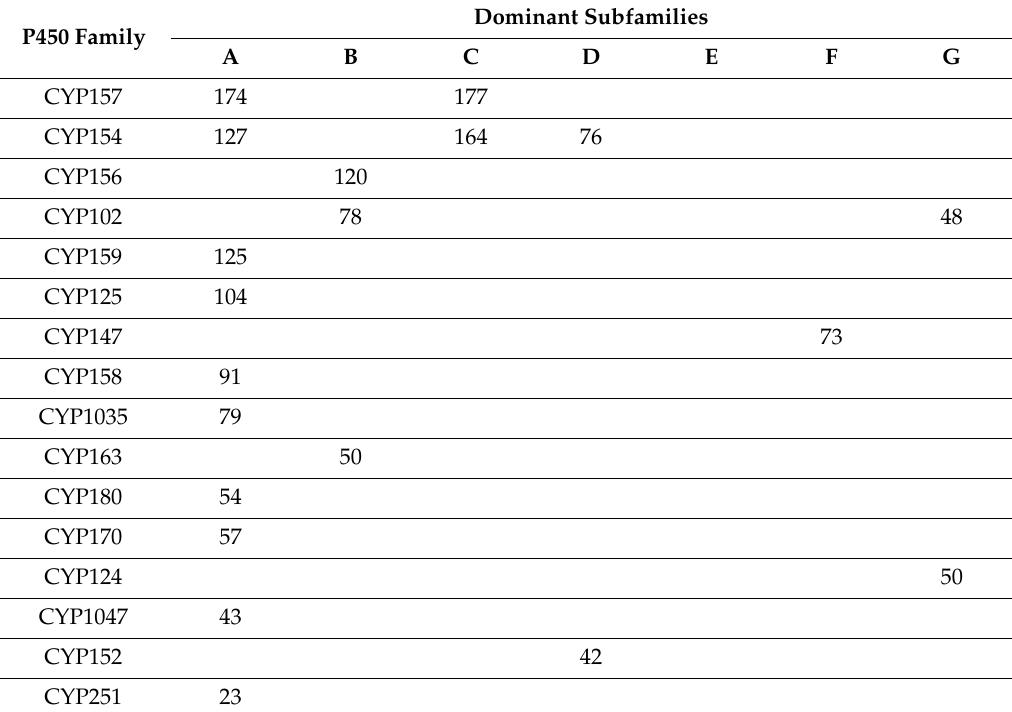
Figure 2. P450 family and subfamily analysis in 203 Streptomyces species. Only the dominant P450 families with more than 40 P450s are shown in the figure. Detailed data on P450 families and subfamilies are presented in Supplementary Table S3. Table 3. P450 subfamily analysis in the dominant families in 203 Streptomyces species. The number of members in the dominant P450 subfamily is presented. Detailed data on di ff erent subfamilies are presented in Supplementary Table